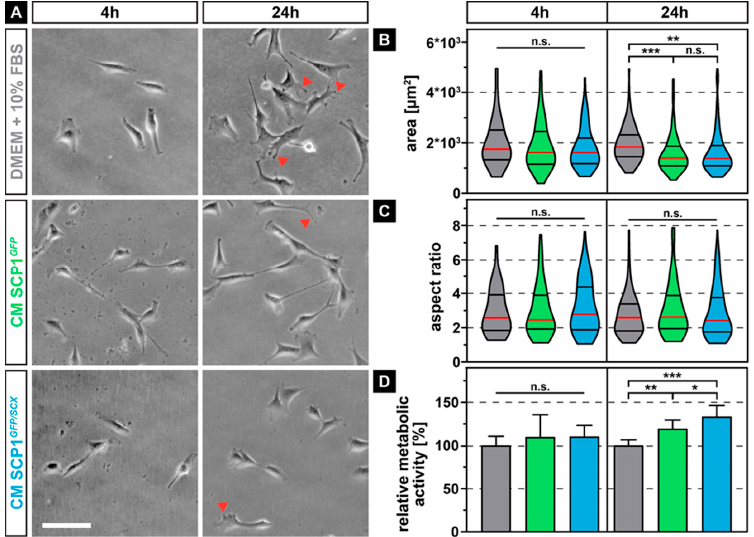
Figure 1. Phase contrast images of C2C12 cells after 4 and 24 hours of exposure to conditioned media (CM) derived from Single clone pick 1 (SCP1) GFP or SCP1 GFP/SCX cells led to smaller cells with fewer filopodia (arrowheads) when compared to myoblasts in normal medium (NM) ( A ). Quantification of the individual cell morphology parameters revealed a significant decrease in cell area ( B ) but not of the aspect ratio ( C ). Long-term treatment (24 h) significantly increased the metabolic activity of C2C12 in CM of SCP1 GFP or SCP1 GFP/SCX cells, when compared to myoblasts in normal medium. Interestingly, the secretome of scleraxis-overexpressing cells led to a higher metabolic activity of C2C12 cells, when compared to CM from SCP1 GFP ( D ). Scale bar: 100 µ m. Violin plots represent the median (red line) and quartiles (black lines). Bar plots represent the mean and SD. * equals p ≤ 0.05, ** equals p ≤ 0.01, *** equals p ≤ 0.001, n.s.: not significant. Data were obtained from three randomly selected field-of-views (FOV) of three independent experiments. At least 75 cells per time point and experimental condition were